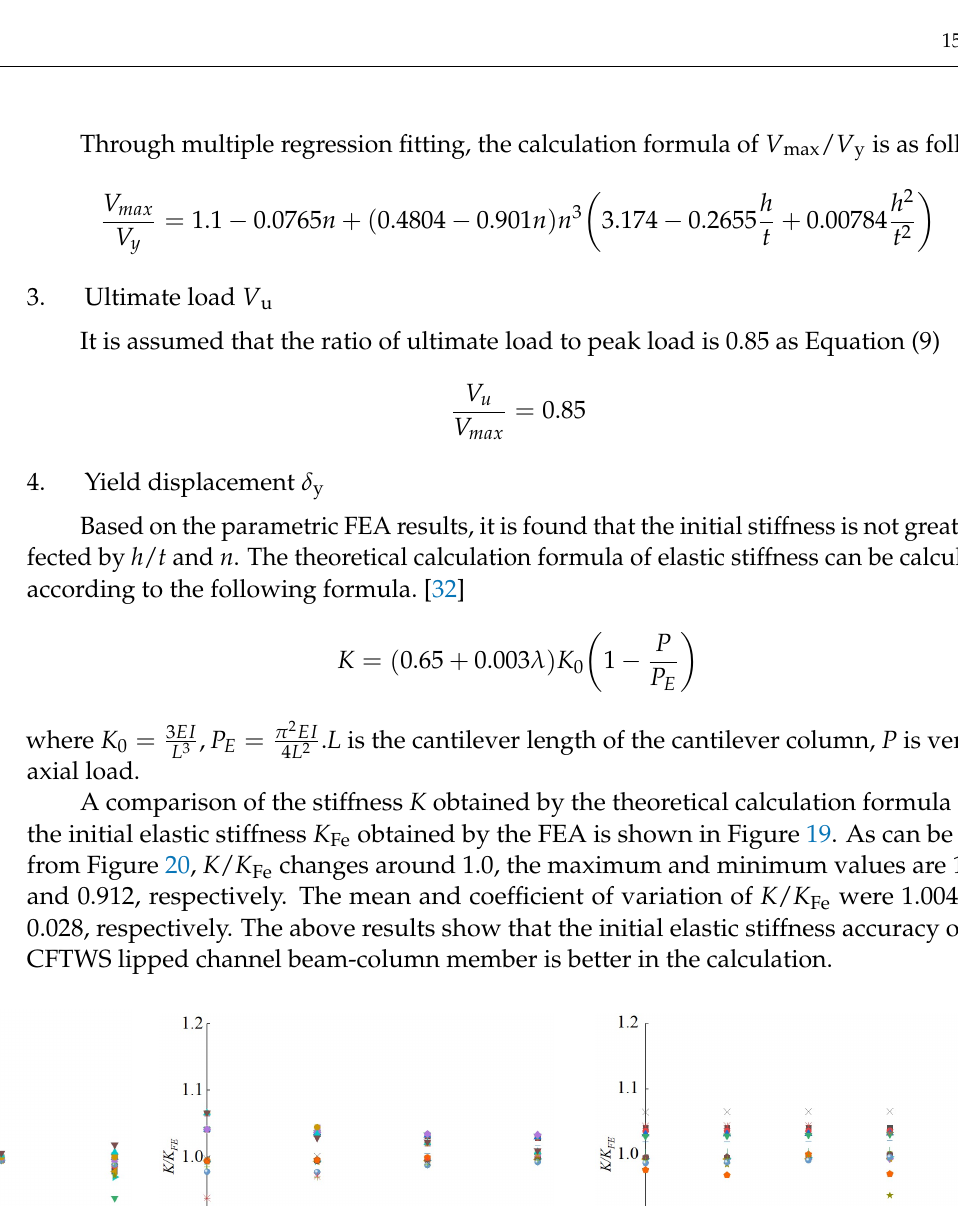
Figure 19. The effect of λ on V max / V y . ( a ) n = 0.1; ( b ) n = 0.2; ( c ) n = 0.3; ( d ) n = 0.4.